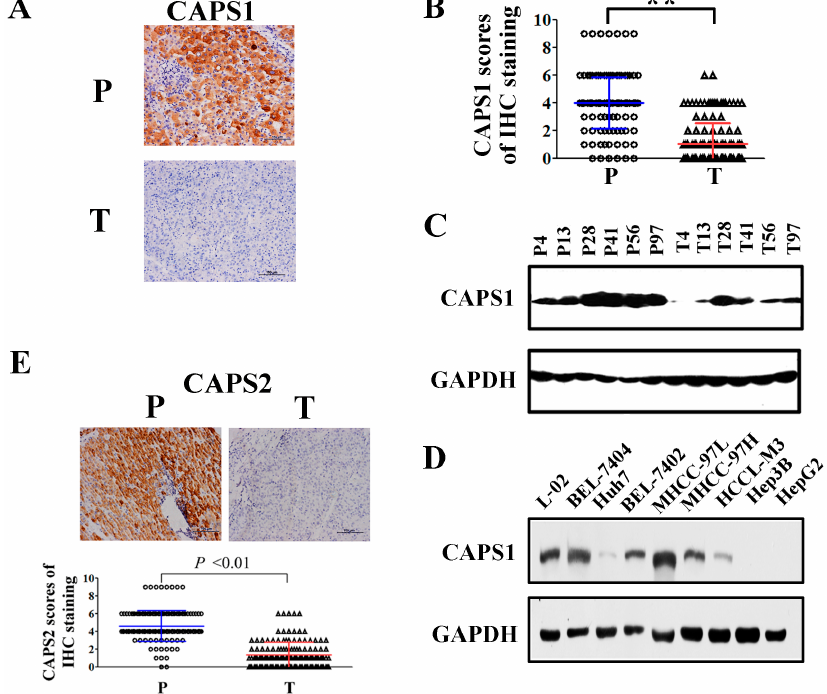
Figure 1. Loss of calcium-dependent activator protein for secretion 1 (CAPS1) expression in clinical hepatocellular carcinoma (HCC) tissues and HCC cell lines. ( A ) Typical patterns of CAPS1 staining in paired HCC tissue specimens. P, peritumoral tissues; T, tumor tissues; ( B ) Scores of immunochemistry staining of CAPS1 in 141 HCC patients. The mean composite score of immunohistochemical (IHC) staining of peritumoral tissues is four (in blue color), while that of tumor tissues is one (in red color). ** p < 0.01; ( C ) Protein expression of CAPS1 in tumor tissues with paired peritumor tissues of six random HCC cases; ( D ) Protein levels of CAPS1 in a normal liver cell line (L-02) and cultured HCC cell lines. The experiment was repeated three times and representative samples are shown; ( E ) Typical patterns of CAPS2 staining in paired HCC tissue specimens ( upper panel) and scores of immunochemistry staining of CAPS2 in 141 HCC patients ( bottom panel). The mean composite score of IHC staining of peritumoral tissues is 4.6 (in blue color), while that of tumor tissues is 1.3 (in red color).